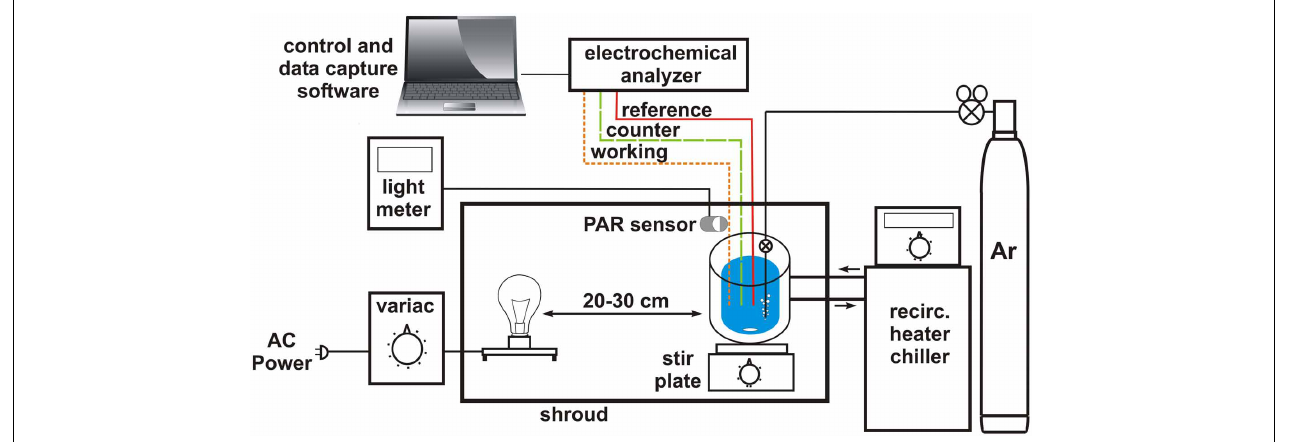
FIGURE 3 | Schematic of experimental apparatus for reproducibly measuring phototrophic sulfide uptake. Details for particular components are provided in the text. “Reference,” “counter,” and “working” refer to the electrodes of the electrochemical analyzer system.